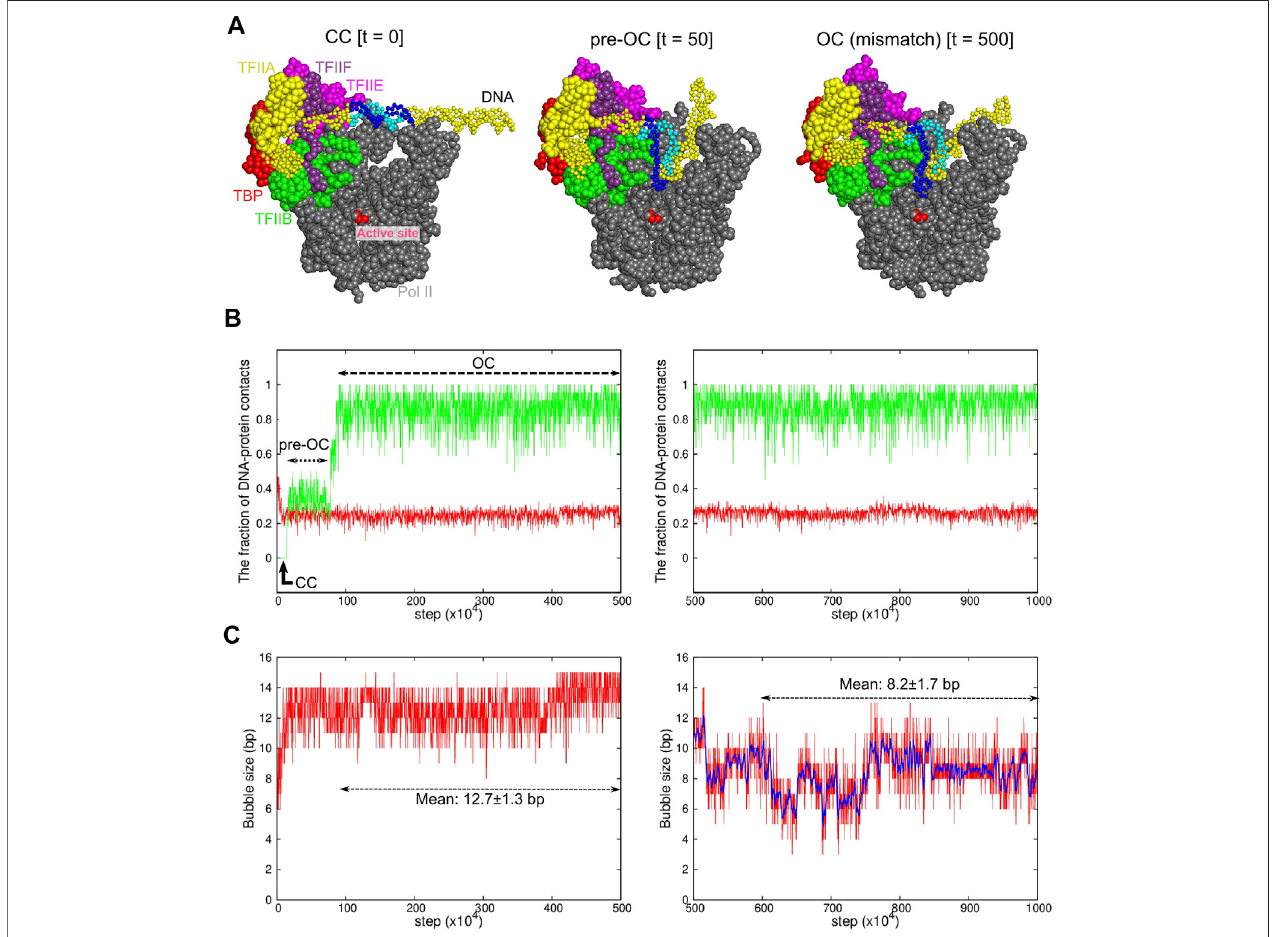
FIGURE2| Coarse-grainedMDsimulationforthetransitionfromtheCCtoOCstates.Resultsofarepresentativetrajectoryareshown. (A) Snapshotsat0MDstep (left, the CC state), at 50 × 10 4 MD steps(center, the pre-OC state), and at 500 × 10 4 MD steps(right,the OCstate with themismatch). Some proteins are not displayed to make DNA visible. The same colors areused as Figure 1A . Blue and cyan region inDNA indicates the 15-bp mismatch region, forming theDNA bubble. (B) The time course ofthe fractionsof protein-DNA contacts speci fi cto CC (red) and OC(green). (C) The time course ofthe DNA bubble size. In (B,C) , the left/right panels are from the fi rst/second halves of MD simulations with/without the DNA mismatch. The blue curve in the right panel in (C) shows a moving average over 11 points.